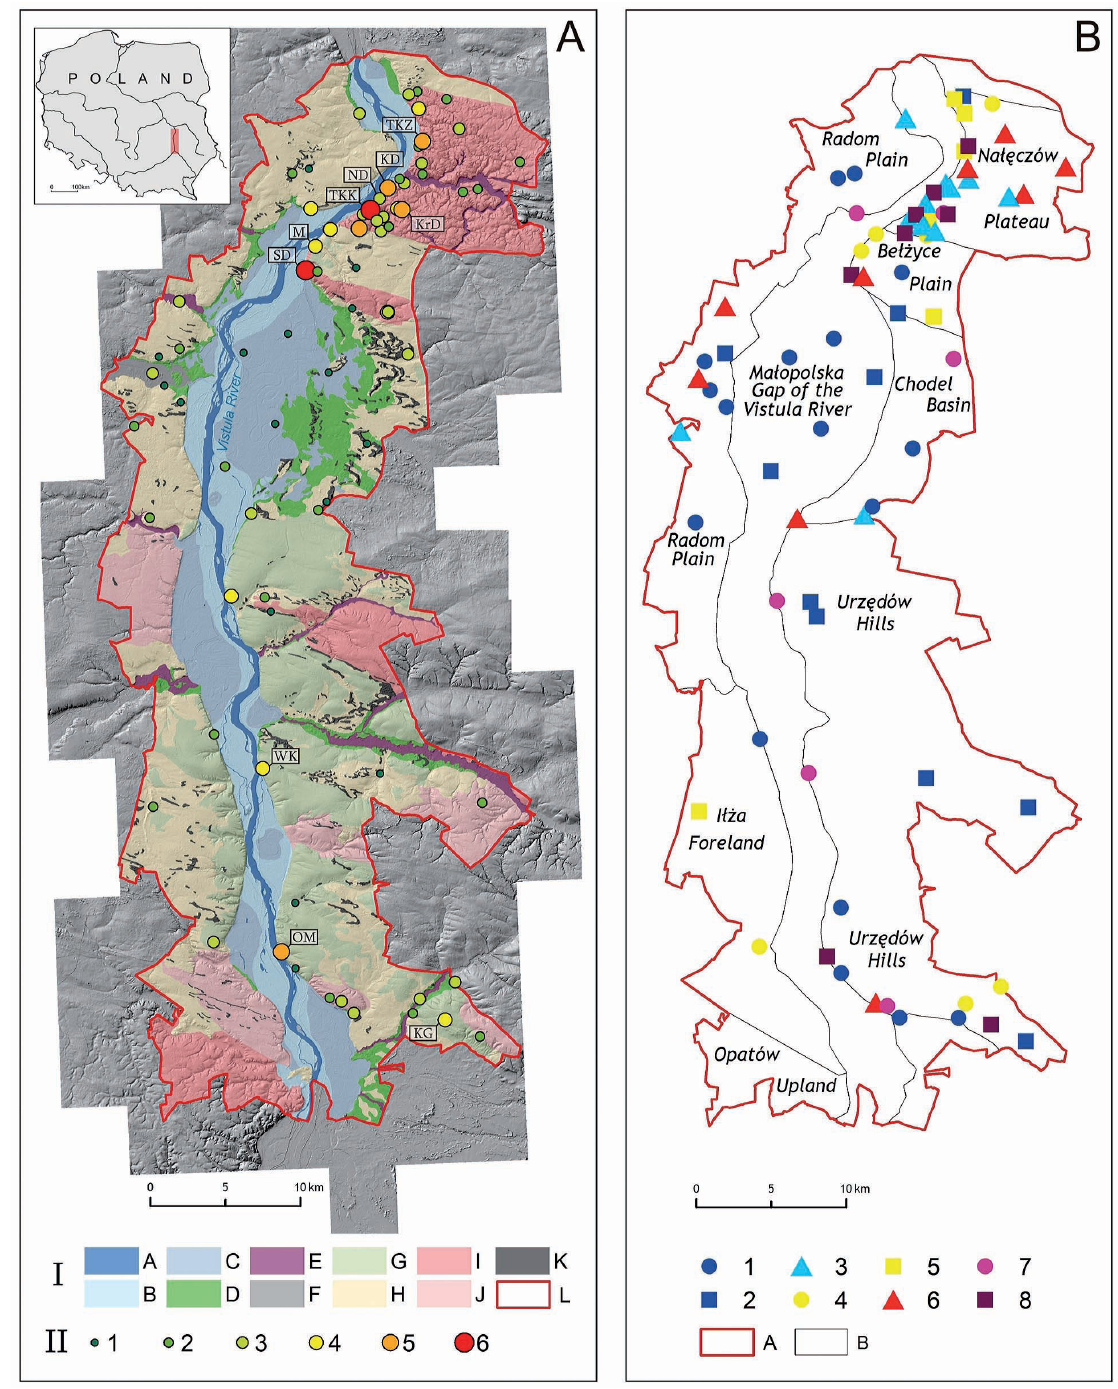
Fig. 1A: Location of the geomorphosites against natural landscapes: I – natural landscapes: A – Vistula River braided channel, B – braided river relief of bottom valley, C – meandering river relief of bottom valley, D – raised terrace, E – deep incised tributary river valleys, F – ice-marginal relief valley, G – denudat- ed uplands, H – glacial and fluvioglacial plains, I – strongly dissected loess cover, J – low dissected loess cover, K – inland dunes, L – geopark border II: geomorphosites classes according to the total score (crescent): 1 – total value 4÷6 points ; 2 – total value 6÷8 points; 3 – total value 8÷10 points; 4 – total value 10÷12 points ; 5 – total value 12÷14 points; 6 – total value 14÷16 points.; TKK, SD … – acronyms explained in the text Fig. 1B: Distribution of sites belonging to the eight geomorphosite groups presented in Table 3 within mesoregions: A – geopark border, B – mesoregion